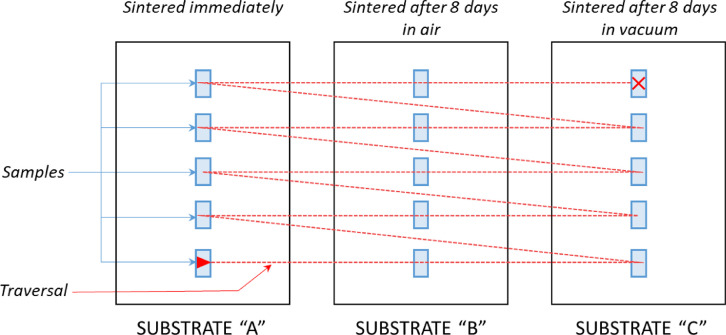
A diagram showing the scheme used for printing and comparing the storage effects for yet-to-be-sintered samples. For each of the three inks, we printed a total of fifteen 8 mm x 3 mm samples across three clean 2” x 3” glass slides using the traversal scheme indicated by the red dashed line. Immediately following deposition, we sintered substrate “A” and analyzed the pads for DC conductivity. Substrates “B” and “C” were stored in air and under vacuum, respectively, for 8 days prior to sintering and DC conductivity analysis.